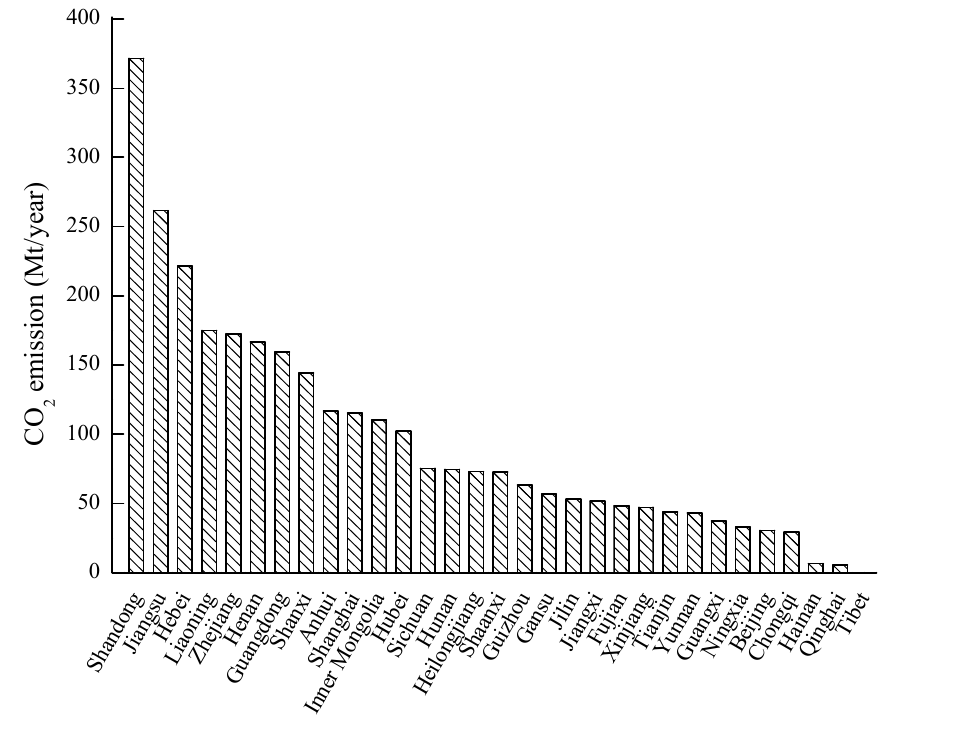
industrial point sources. 2